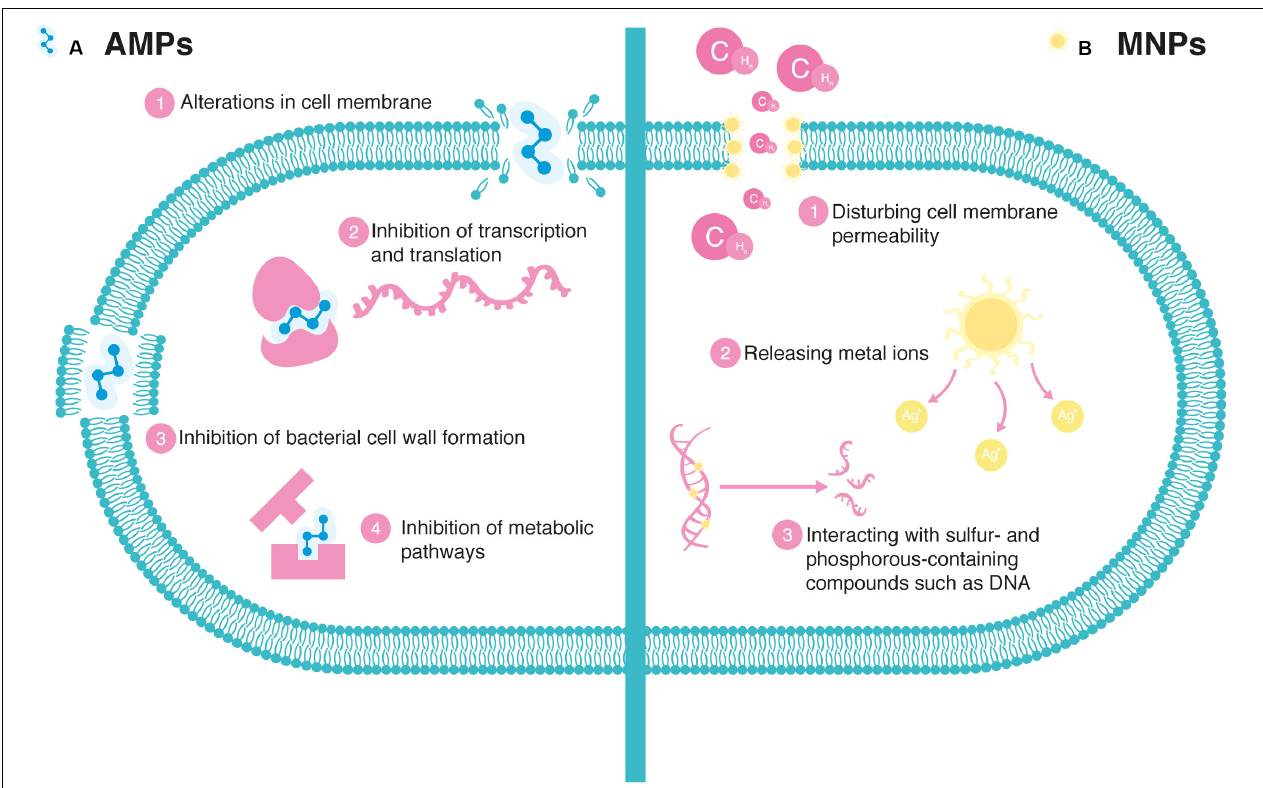
FIGURE 1 | Mechanism of antimicrobial action in bacteria: (A) General mechanisms of action of antimicrobial peptides (AMPs). AMPs act through different mechanisms (Le et al., 2017) such as 1. Alteration in membrane integrity via electrostatic interaction with negatively charged cell membranes which kill cells, 2. Inhibition of DNA synthesis by (i) cross-linking with single- or double-stranded DNA, (ii) prevention of the DNA relaxation by inactivation of DNA topoisomerase I, and (iii) blocking of DNA replication by trapping the gyrase-DNA complex; and protein synthesis by (i) inhibition of protein translation by targeting the ribosomes, (ii) interrupting the protein-folding pathway, and (iii) rapid proteolytic activity causing the degradation of some DNA replication-associated proteins, leading to secondary inhibition of DNA synthesis, 3. Inhibition of bacterial cell wall formation by alteration of the alternating amino sugars in linear form that cross-link via peptide bridges to form the peptidoglycan layer, and 4. Inhibition of metabolic pathways by alteration of nucleic acid metabolism, including nucleotide transport and metabolism, nucleobase, nucleoside, and nucleotide interconversion. (B) Mechanisms for antimicrobial action of metal nanoparticles (MNPs). MNPs act via the following (Shaikh et al., 2019). 1. MNPs disturb cell membrane permeability by interfering with metabolic pathways and inducing changes in membrane shape and function. 2. When MNPs are in solution, metal ions are released in the environment surrounding. Metal ions generate reactive oxygen species (e.g., oxygen ions and hydroxyl radicals) and induce oxidative stress in bacteria. Oxidative stress is a key contributor in altering the bacterial membrane permeability and thus can damage cell membranes. Also, metal ions may cause cell structural changes and aberrant enzyme activities, which perturb normal physiological processes. 3. Interaction with sulfur- and phosphorous-containing compounds such as DNA, which prevent DNA from unwinding and